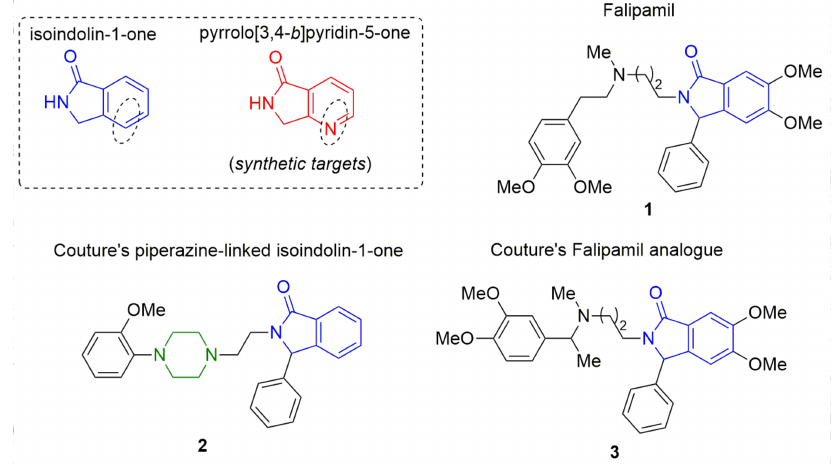
Figure 1. Isoindolin-1-one and one of its aza-analogues (pyrrolo[3,4- b